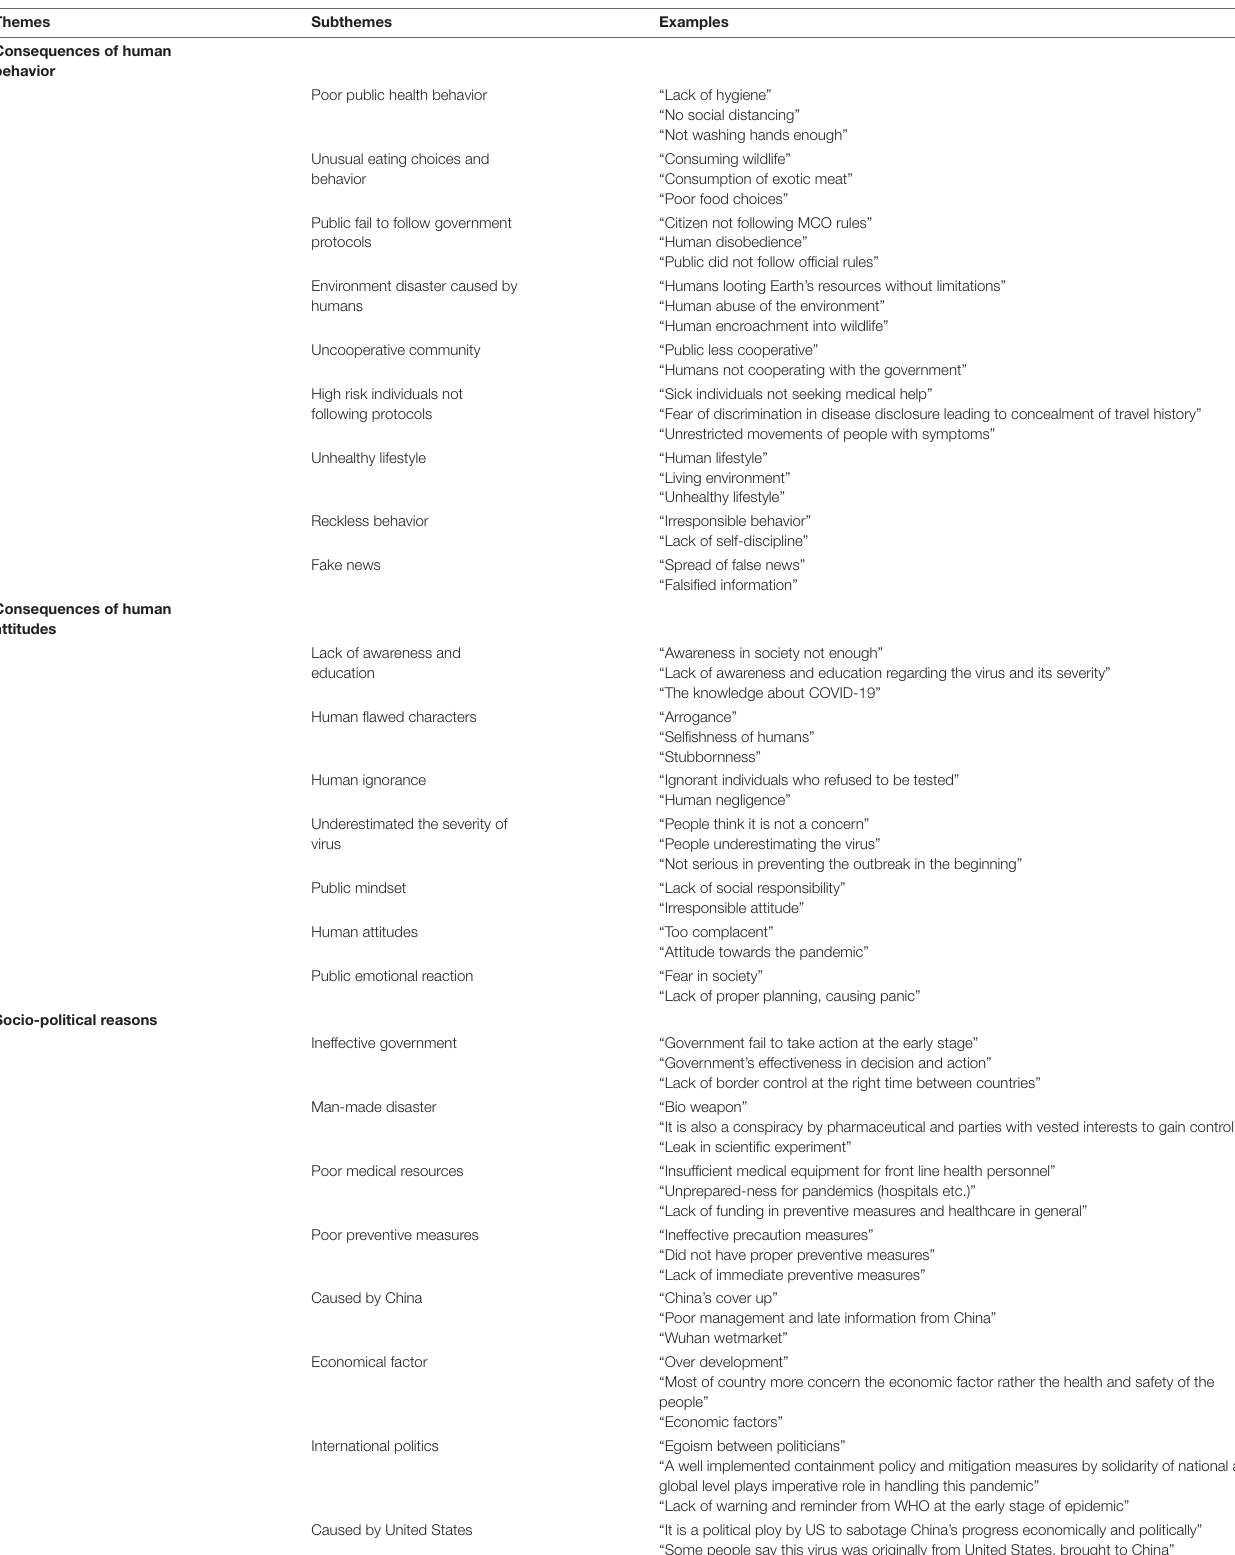
TABLE 5 | Themes, subthemes, and examples of pandemic causal representation ( N = 608).